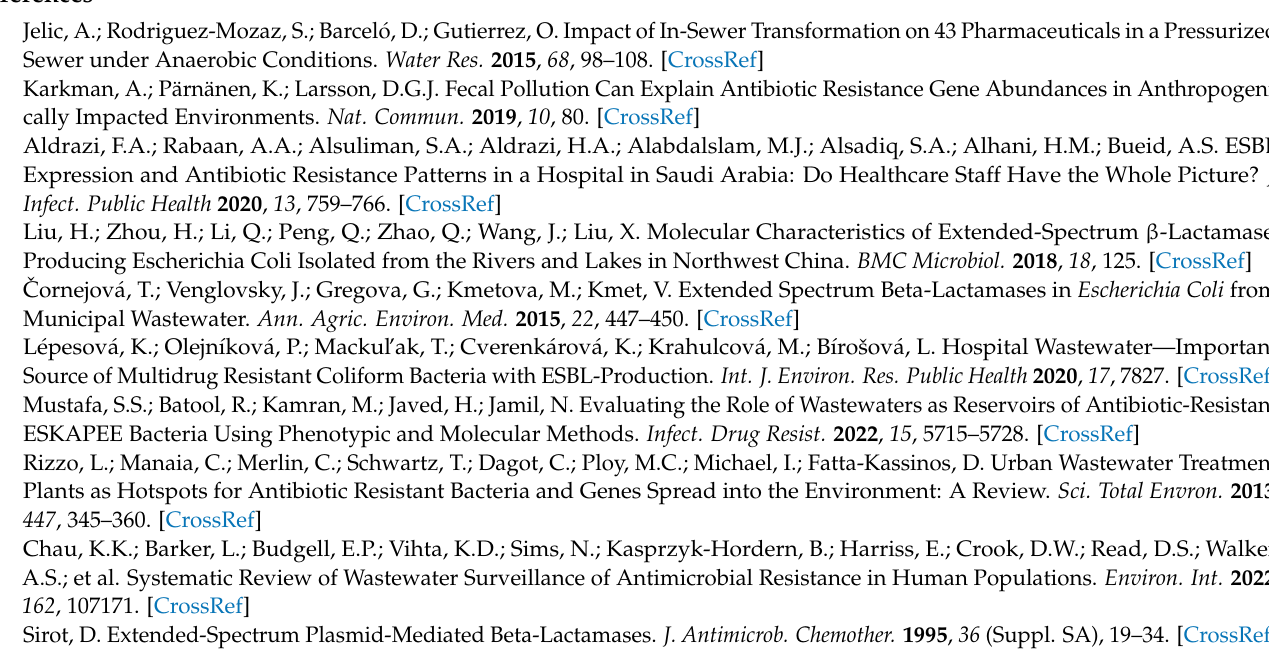
Table S2. Antibiotic resistance profile; Figure S1. Double disc diffusion test for ESBLs; Figure S2. Modified Hodge test; Figure S3. Detection of ESBL genes (multiplex PCR); Figure S4. Detection of Carbapenemase genes (multiplex